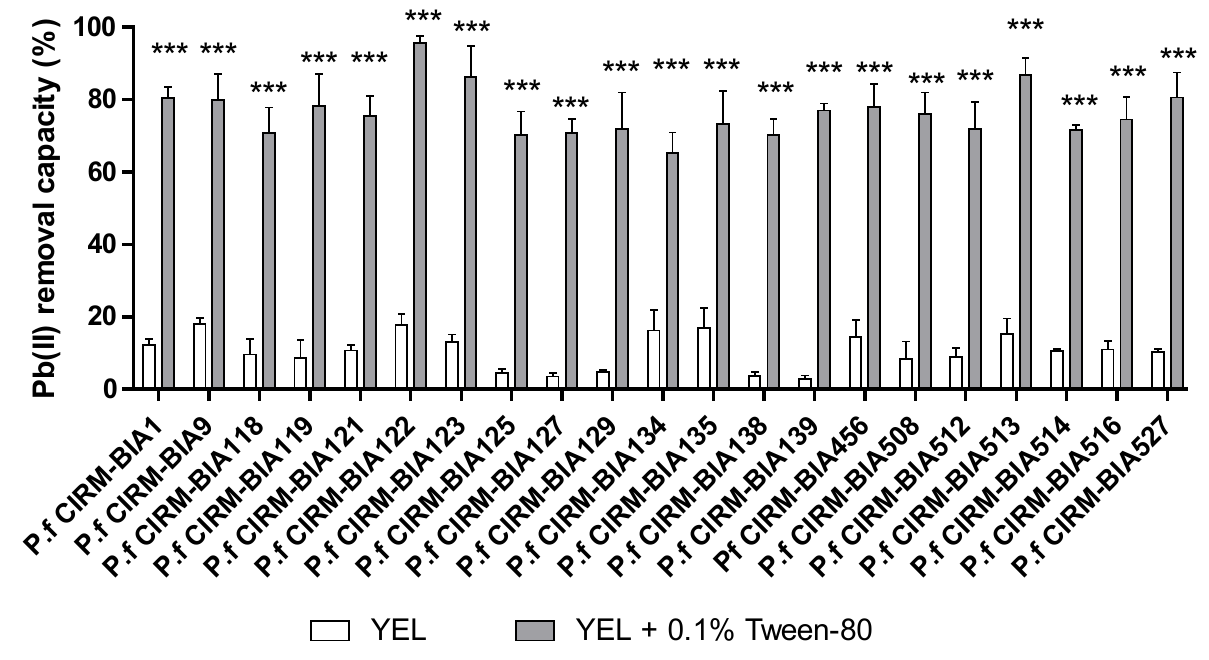
Figure 2. The Pb(II) removal ability of 21 P. freudenreichii strains treated with Tween ® 80. Bacteria were grown in YEL medium (white bars) alone and then treated (or not) with 0.1% Tween ® 80 (YEL + 0.1%) (grey bars). Data are expressed as the mean ± SD % of Pb 2+ removed from the solution (starting concentration: 25 ppm) in triplicate experiments (see the Methods section). *** p < 0.001 for YEL vs. YEL + 0.1%T, with the indicated strain.